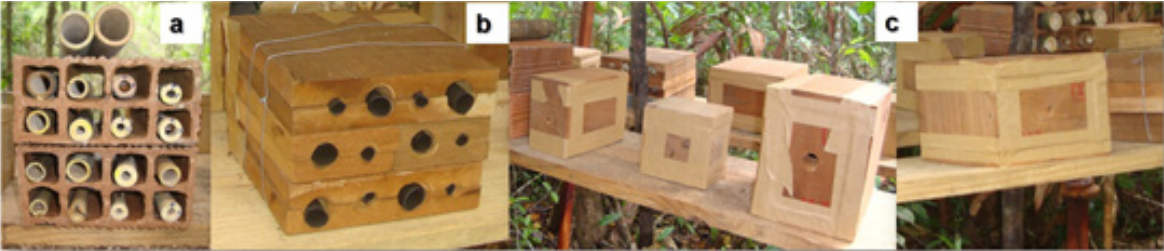
Figure 3. Trap-nests installed in the Baturité Massif, State of Ceará, Brazil: a) dry bamboo internodes; b) tubes made of black paperboard and c) wooden boxes for solitary